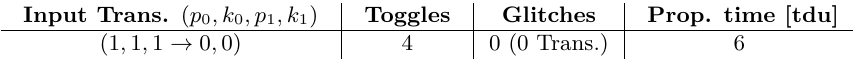
Table 5: Number of gate toggles and glitches caused by the exemplary input transition and the total propagation time.